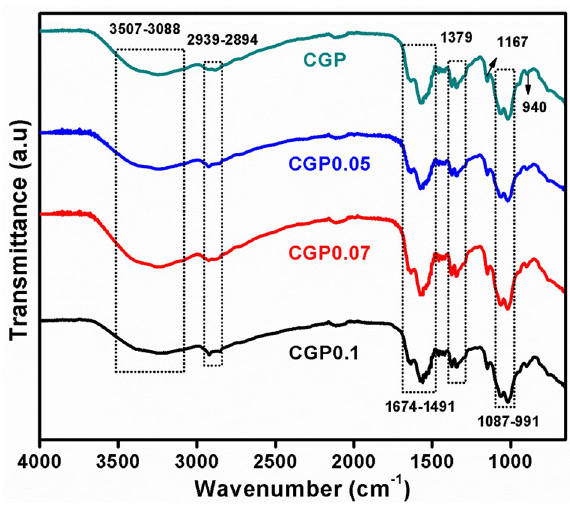
Figure 2. FTIR spectra of CGP hydrogels in the range of 4000–650 cm −1